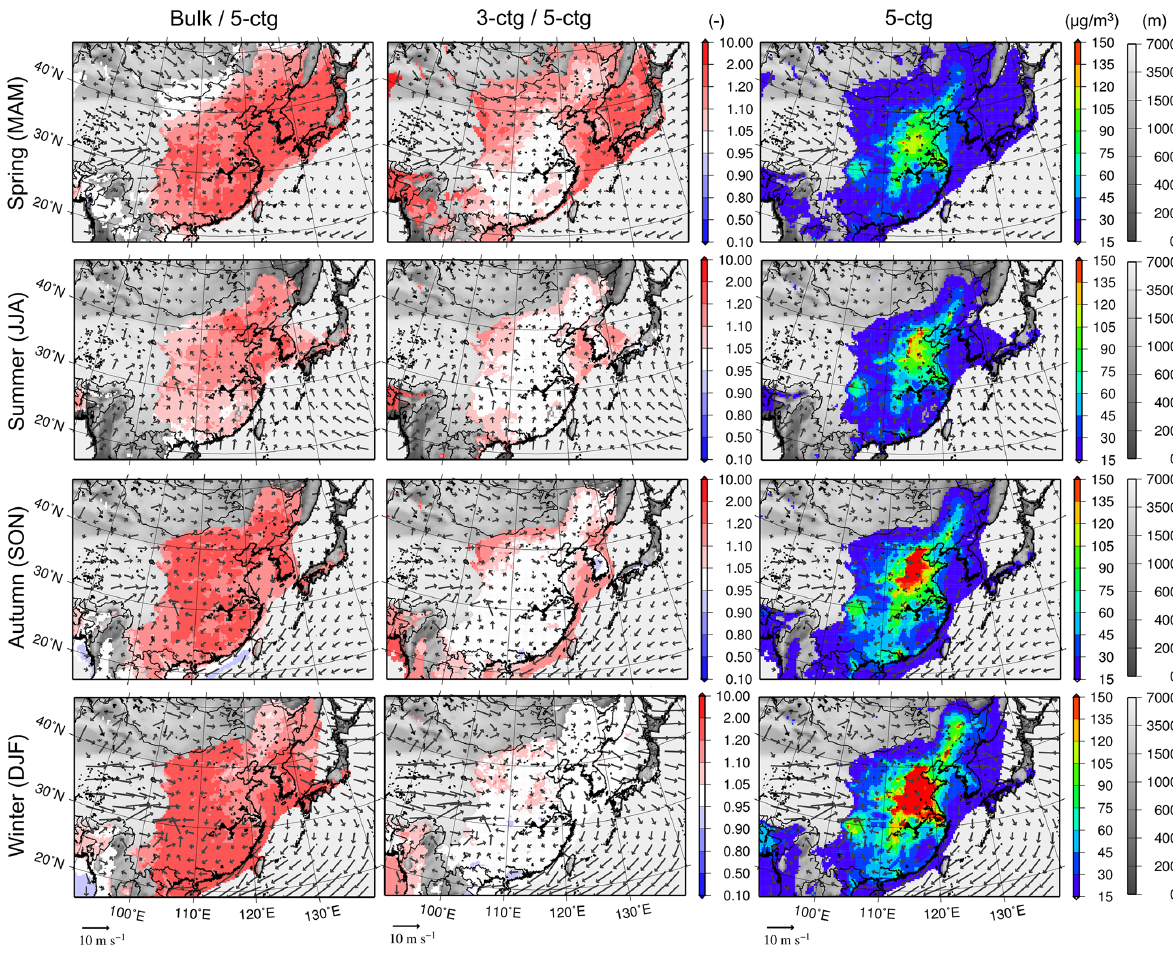
Figure 5. Same as Figs. 3 and 4 but for PM 2 . 5